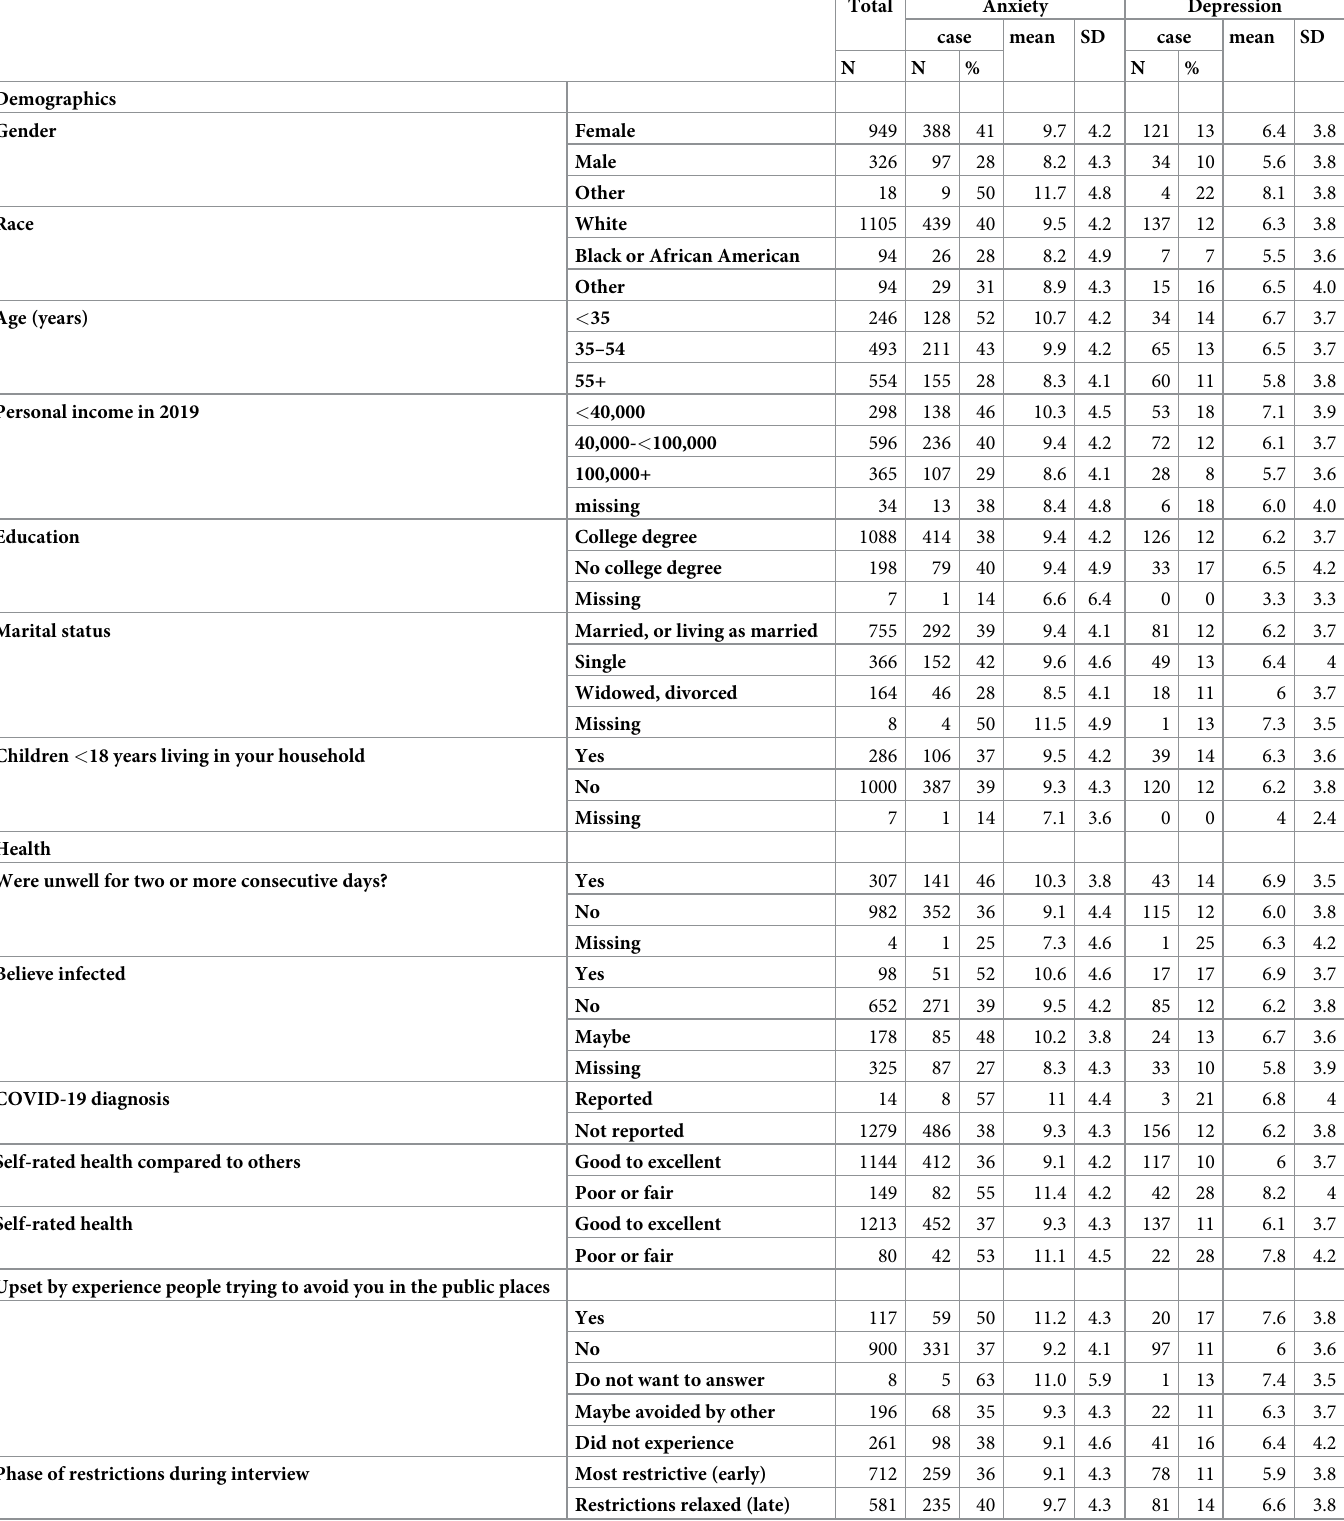
Table 1. Demographics and self-reported health in relation to rates (in %) of Hospital Anxiety and Depression Scale scores above � 11 (case) plus mean and stan- dard deviations (SD) of the scores among 1,293 participants in survey of adult residents of Philadelphia, PA, during the first wave of COVID-19